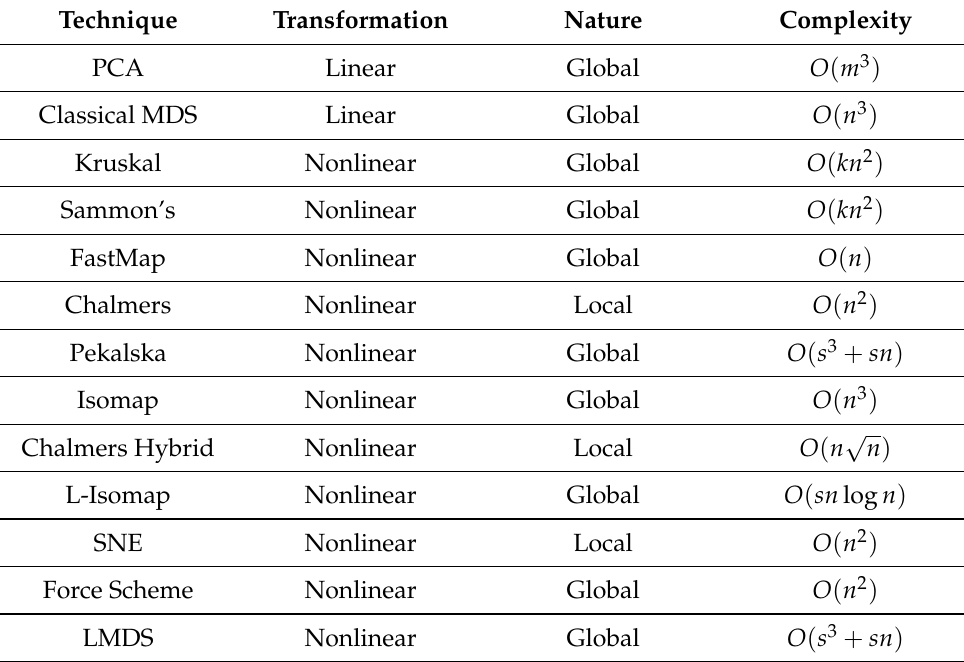
Table 1. Multidimensional projection methods. The column “Complexity” presents the computational load related with the amount of instances ( n ), dimensions ( m ), iterations ( k ), samples ( s ), and graph edges ( E